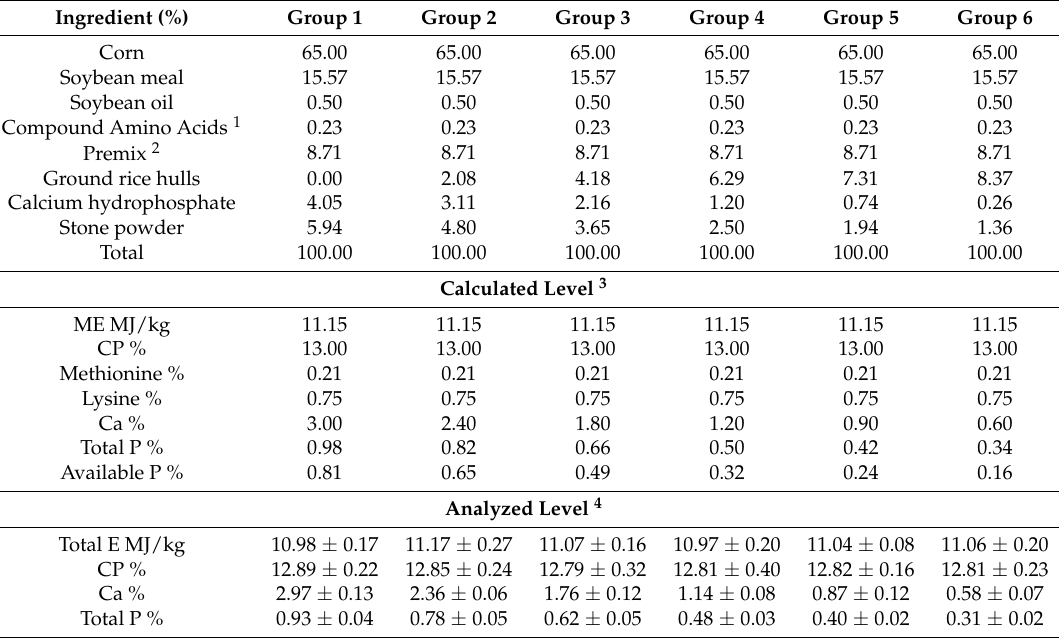
Table 1. Composition and nutrient levels of the